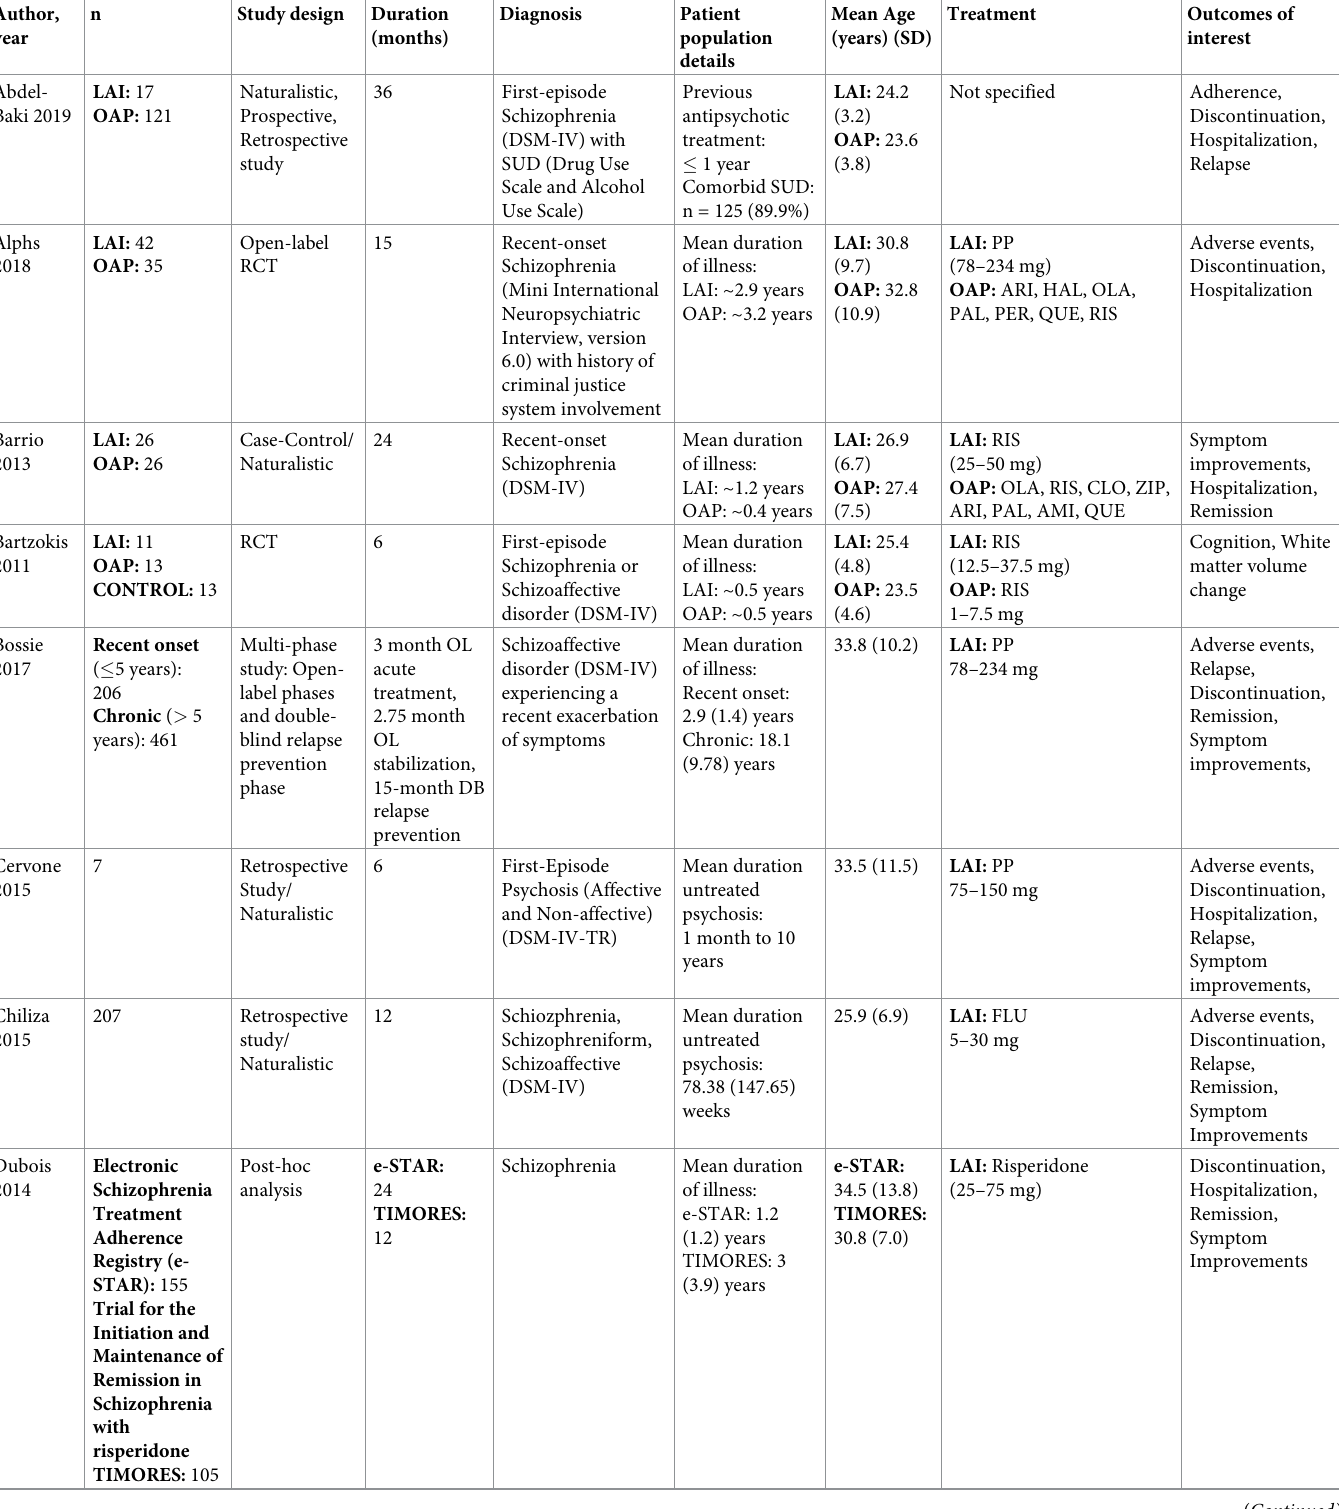
Table 1. Summary of included